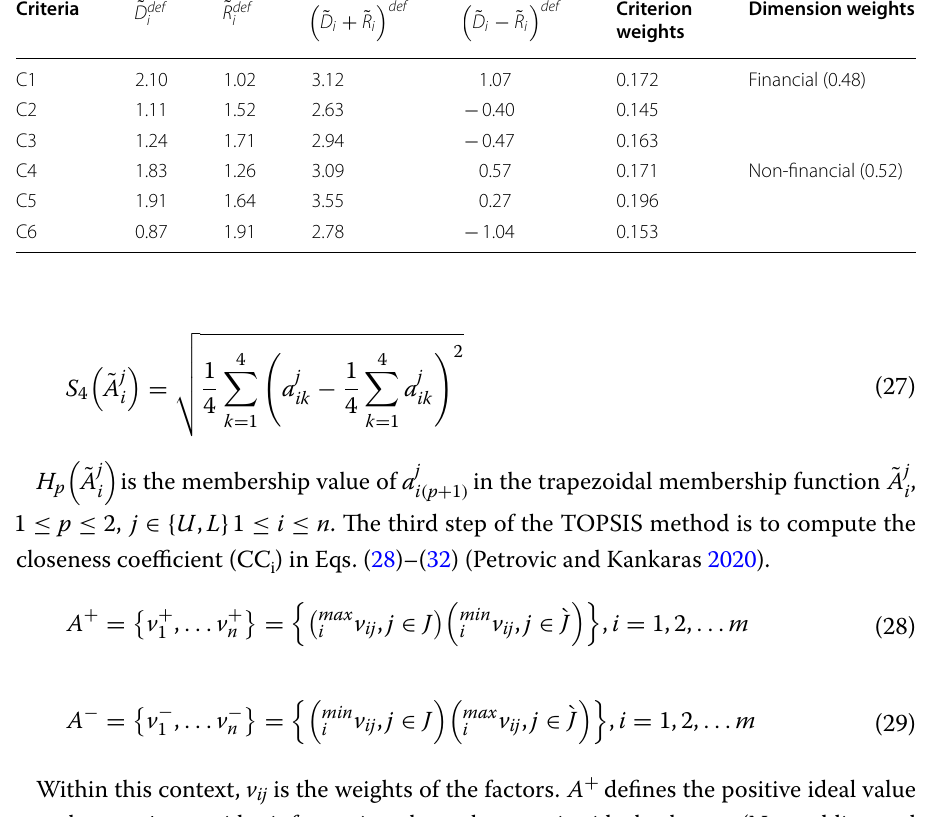
Table 6 Weighting results of criteria and dimensions. Source : Author’s calculations